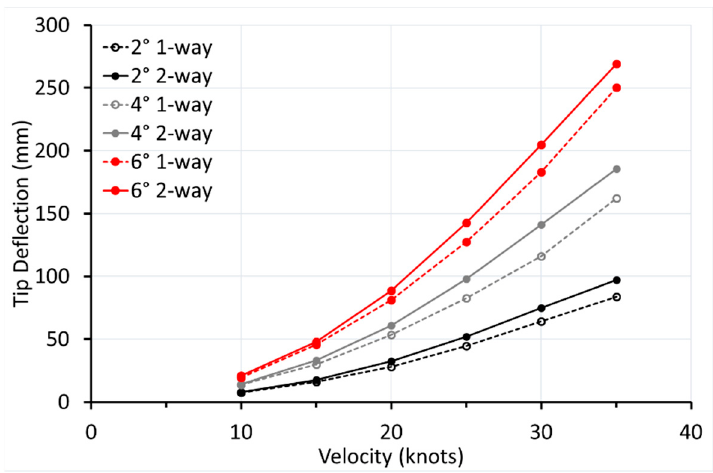
Figure 9. Tip deflection vs. velocity.